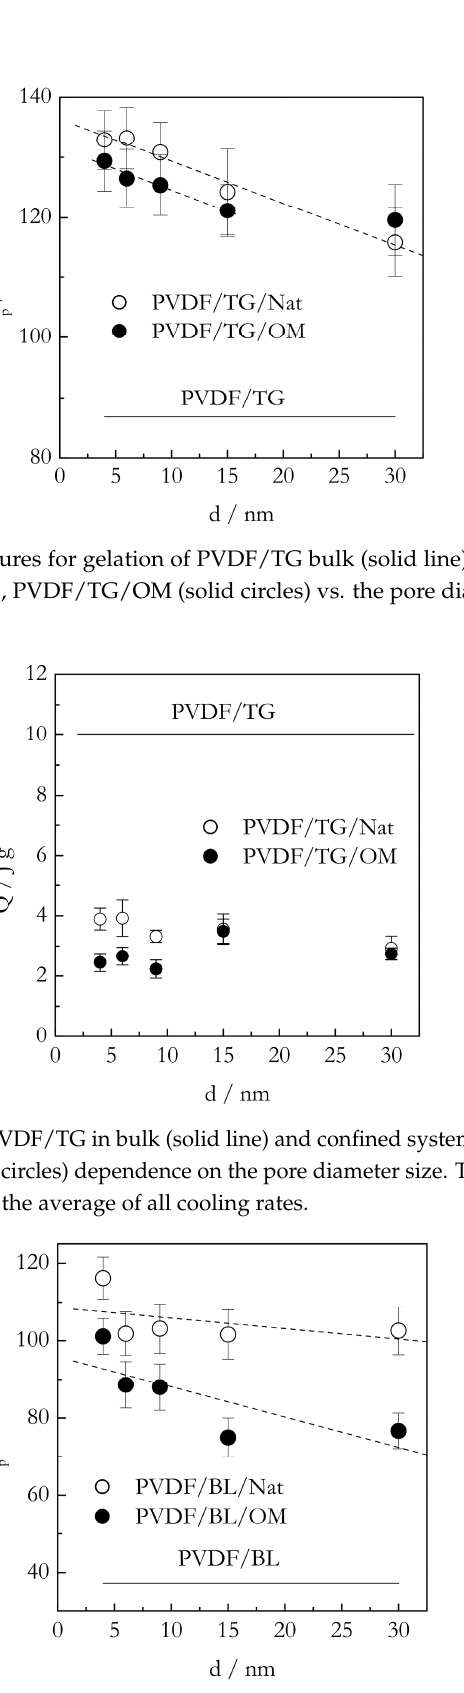
Figure 7. DSC peak temperatures for gelation of PVDF/BL in bulk (solid line) and confined systems PVDF/BL/Nat (open circles), PVDF/BL/OM (solid circles) vs. the pore diameter. Dashed line is a guide to the eye.